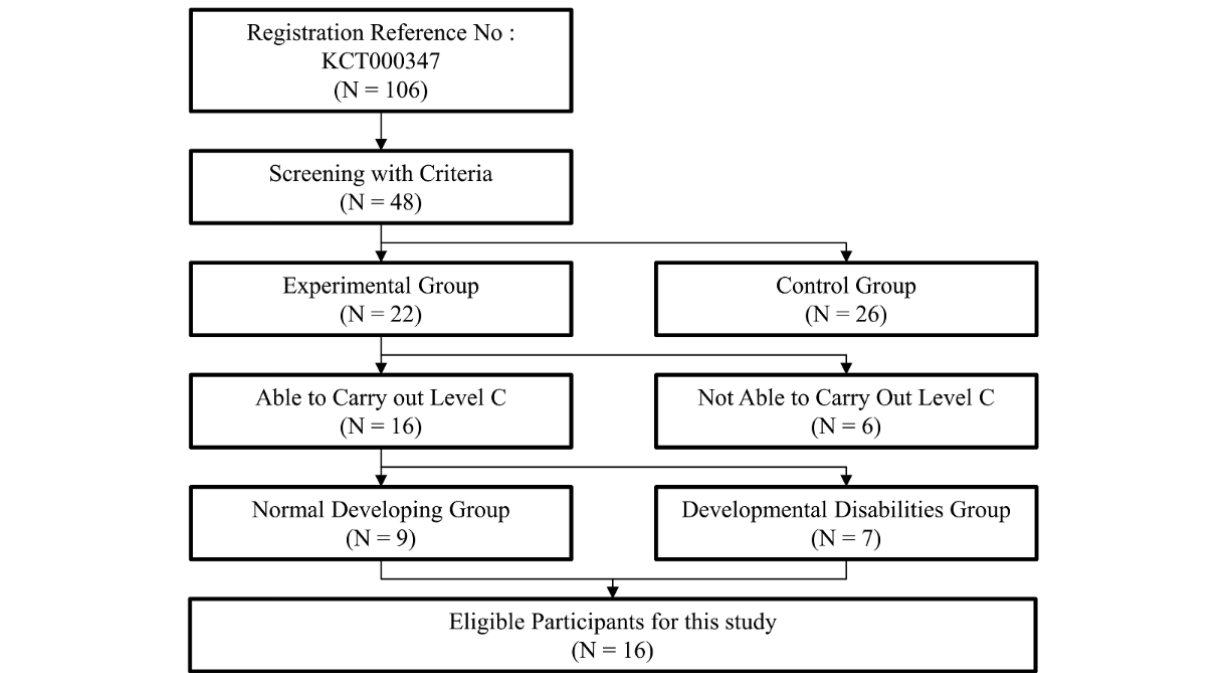
Figure 1. Participant selection flow